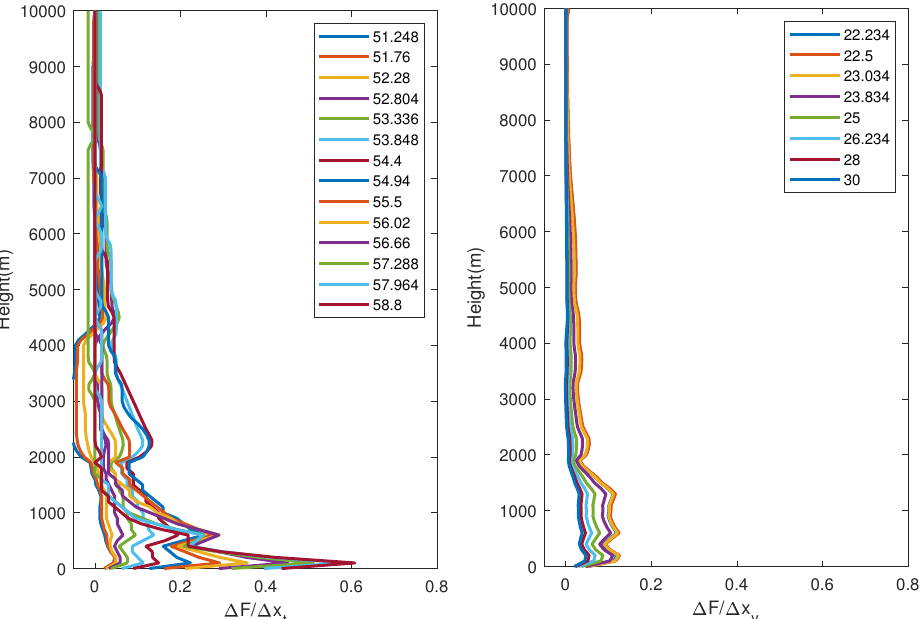
Figure 3. Jacobian matrix of temperature ( left ) and water vapor ( right ), at UTC 00:00, 4 July